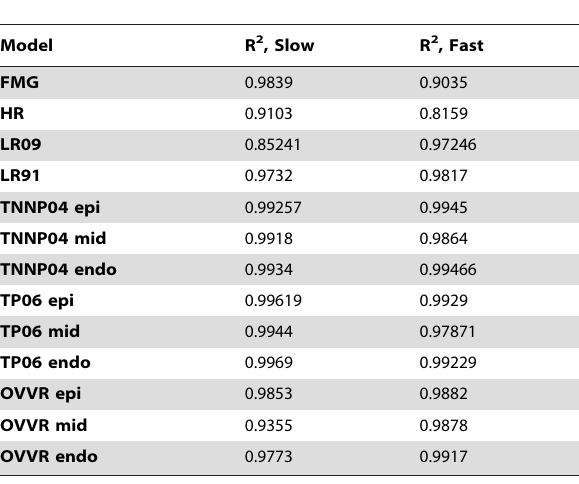
Table 1. Coefficient of determination (R 2 ) for linear regression